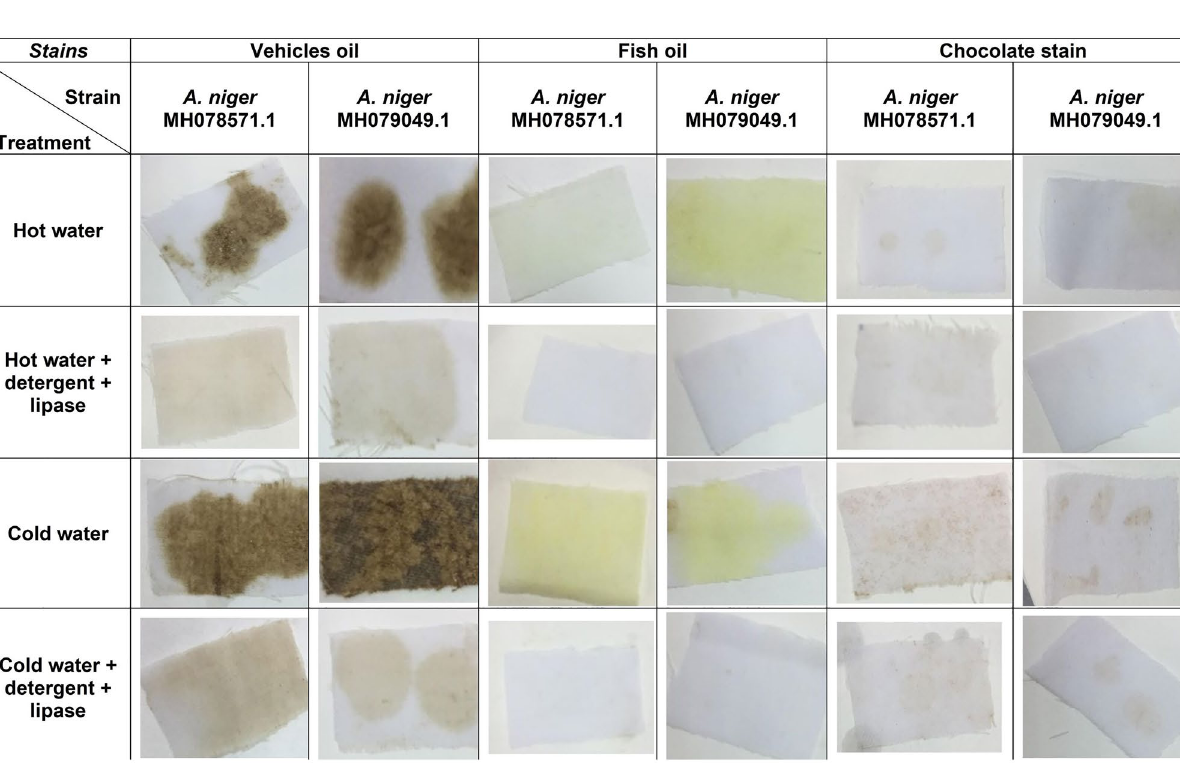
Figure 1. The effect lipase enzyme from both A. niger MH078571.1 and A. niger MH079049.1 on removing vehicles oil stain, fish oil stain, and chocolate